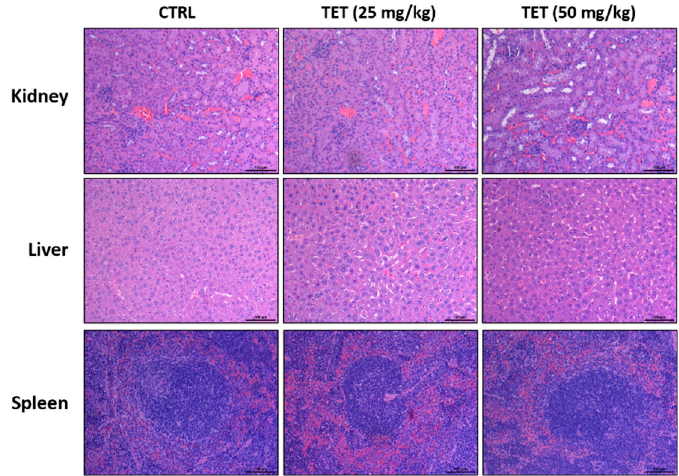
Figure 7. The examinations of TET-induced acute toxicity from xenografted GBM 8401/ luc2 -cell- bearing mice. After treatment, tissues such as kidney, liver, and spleen were isolated from each mouse and further examined the pathology photograph by H & E staining under the microscope with 100 times magnification as described in Materials and methods. Scale bar = 100 μ m.